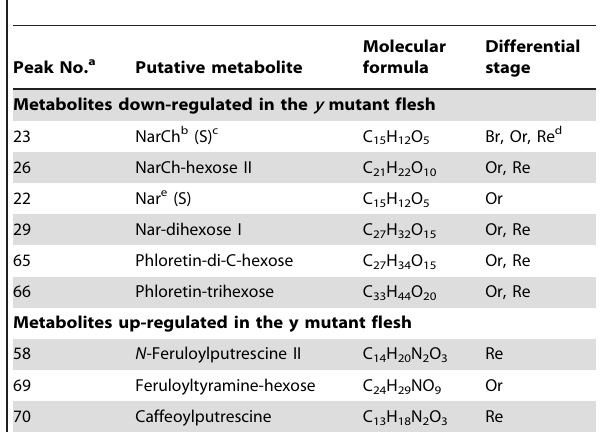
Table 3. UPLC-QTOF-MS detected metabolites that are differentially produced between y mutant and wt fruit flesh